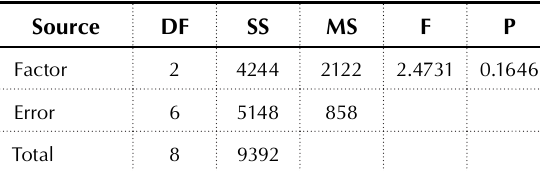
Table 10. ANOVA test results